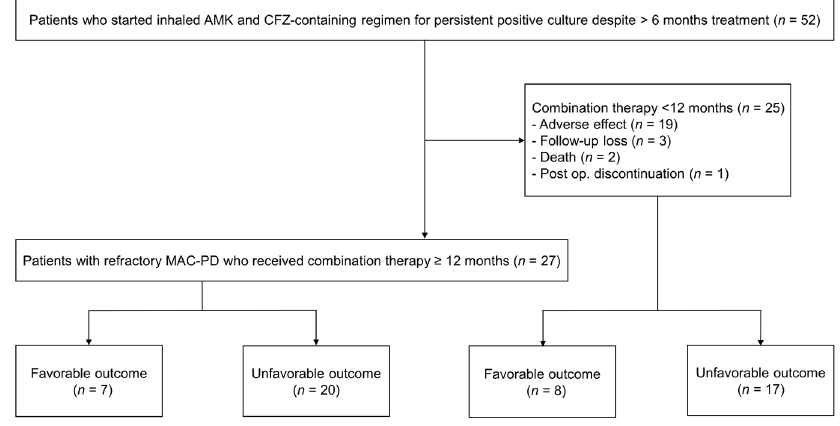
Figure 1. Flow diagram of study population.